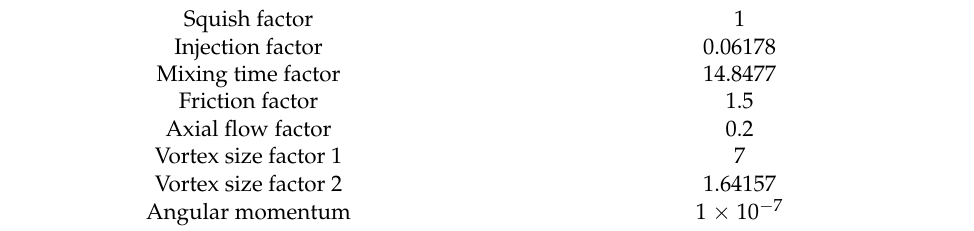
Table 5. Input parameters of the turbulence model with optimized values.